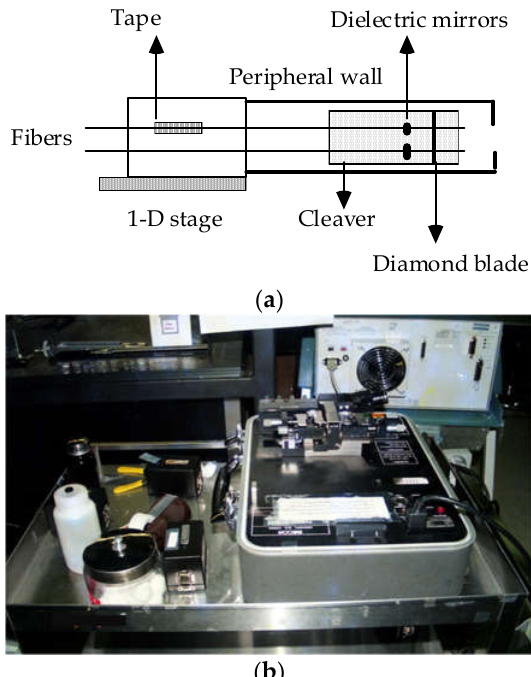
Figure 3. ( a ) Top view of the alignment of both fibers with dielectric mirrors on a cleaver and an adjustable 1D stage. ( b ) Contour of a splicer.